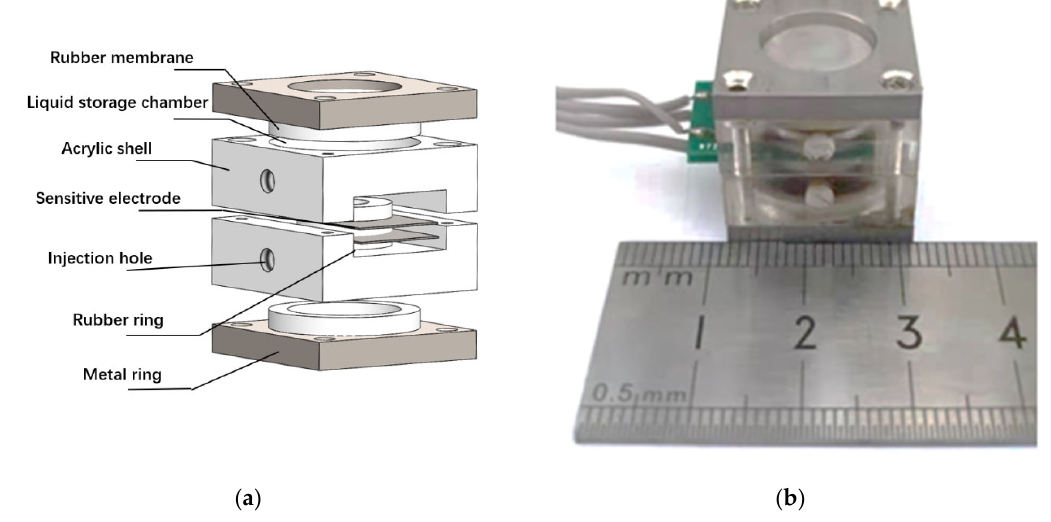
Figure 5. ( a ) The schematic diagram of electrochemical vibration sensor assembly. ( b ) The electrochemical vibration sensor after assembly.